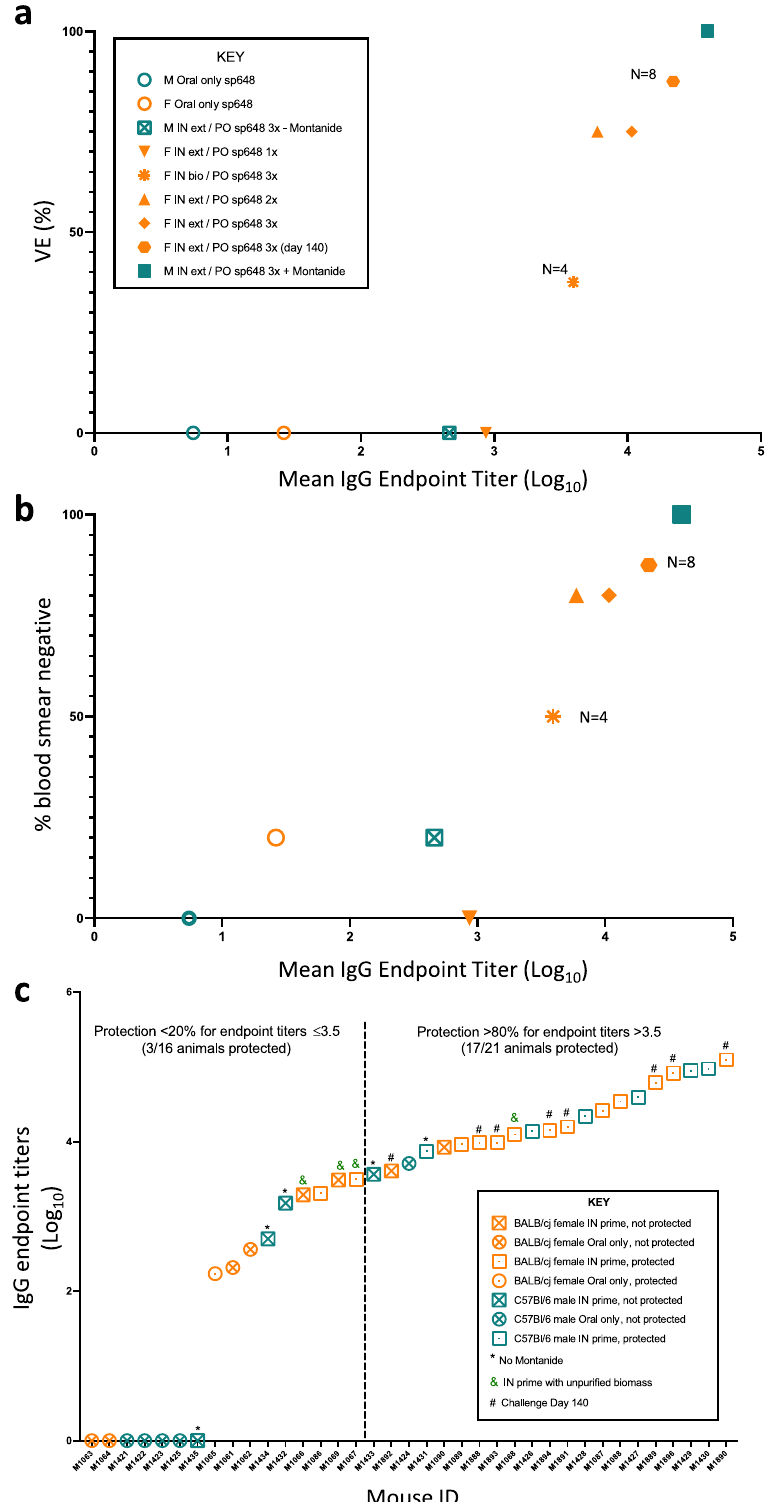
Fig. 6 Relationship between pre-challenge anti-PfCSP antibody titers and protection from challenge. a Vaccine Ef fi cacy (VE) was calculated for each group as 1 – risk ratio (×100) and plotted against respective mean endpoint titer. b The percentage of mice that were blood smear negative post-challenge was plotted against the respective mean NANP-speci fi c IgG endpoint titer at the time of challenge. For A and B for all groups except where indicated, challenge took place on day 70 of the respective trial. In a – b , each data point represents a group of mice as shown in the inset key ( n = 5 mice/group unless otherwise indicated). c Individual mouse NANP-speci fi c IgG endpoint titers at the time of challenge were plotted compared to the challenge outcomes. Each data point represents an individual mouse with the corresponding groups identi fi ed in the inset